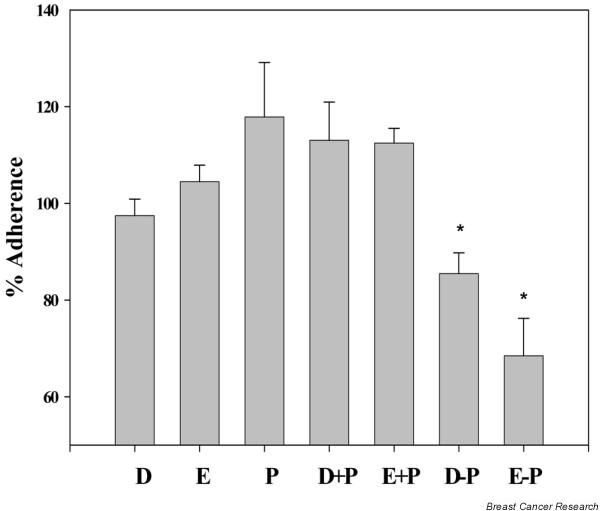
Effect of propofol-docosahexaenoic acid (propofol-DHA) and propofol-eicosapentaenoic acid (propofol-EPA) conjugates on cell adhesion. MDA-MB-231 cells (104) were incubated in vitronectin-coated plates in the presence of 25 μM DHA (D), 25 μM EPA (E), 25 μM propofol (P), 25 μM each of D+P, 25 μM each of E+P, and 25 μM propofol-DHA (D-P) or 25 μM propofol-EPA (E-P) for 45 min. The control cells were treated with equal amounts of ethanol. Cells adhering to the plates were quantified by staining and measurement of the absorbance in a spectrophotometer as described in the text. Results are means ± SEM for four experiments and are presented as the percentages of adhered cells in comparison with the controls. The results were analyzed by analysis of variance and Dunnett's multiple comparison test to control the Type I experimental wise error. Significant differences from the control (P < 0.05) are indicated with an asterisk.